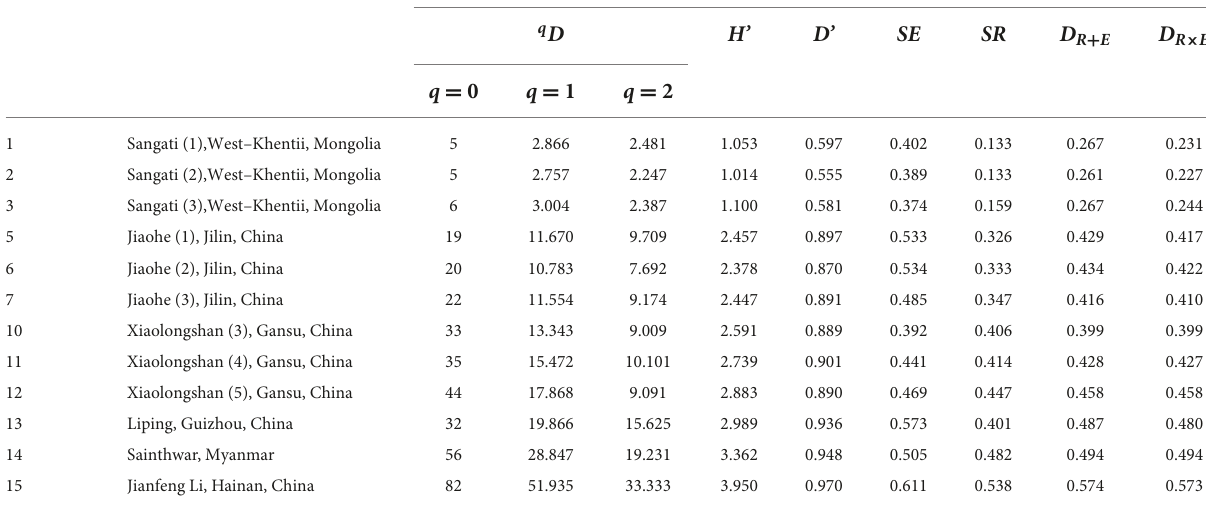
TABLE 4 Tree species diversity of natural forests locating in different climate zones. Plot